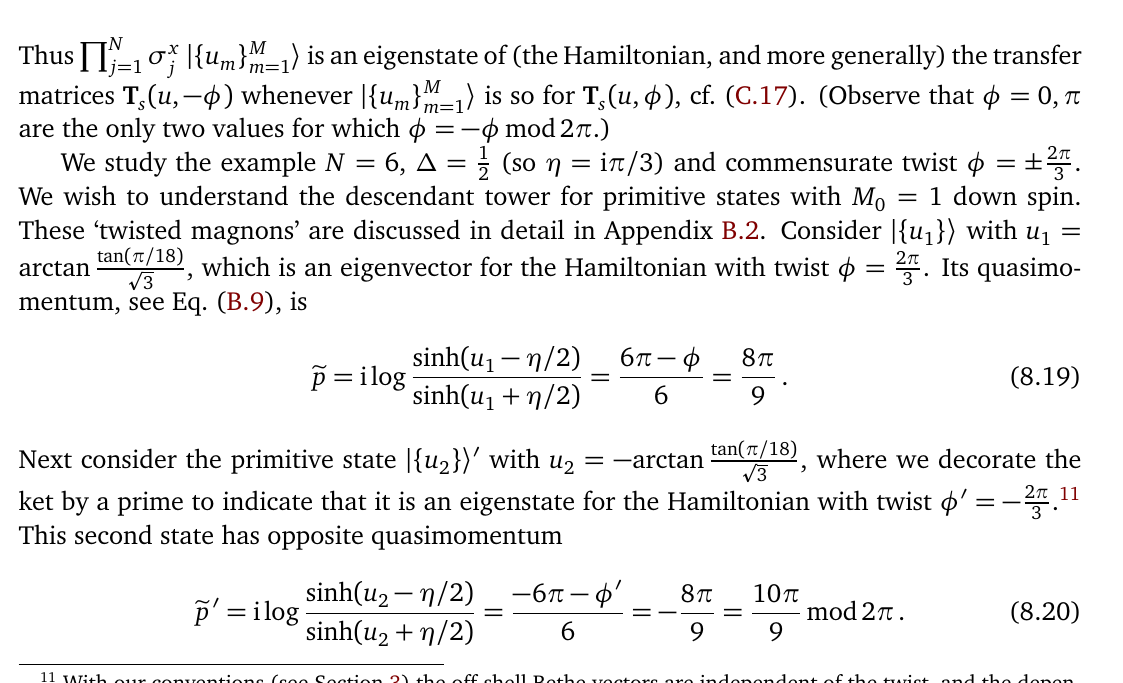
Figure 6: Illustration of descendant towers from degenerate primitive states at = 1,2 with Bethe roots at infinity for N = 12, ∆ = 1 / 2, φ = 0. Global spin M 0 reversal acts by reflection through the middle of the figure: the states with the same colour are pairs corresponding to each other beyond the